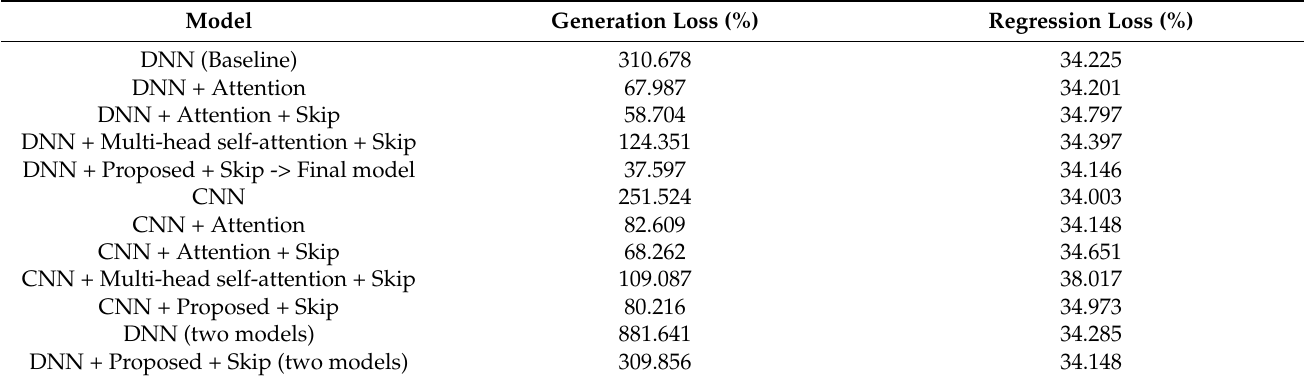
Table 3. Evaluation results using the test set for the baseline model with deep learning modules. Deep neural network (DNN) with the proposed module was selected as the final multitask learning (MTL) model.